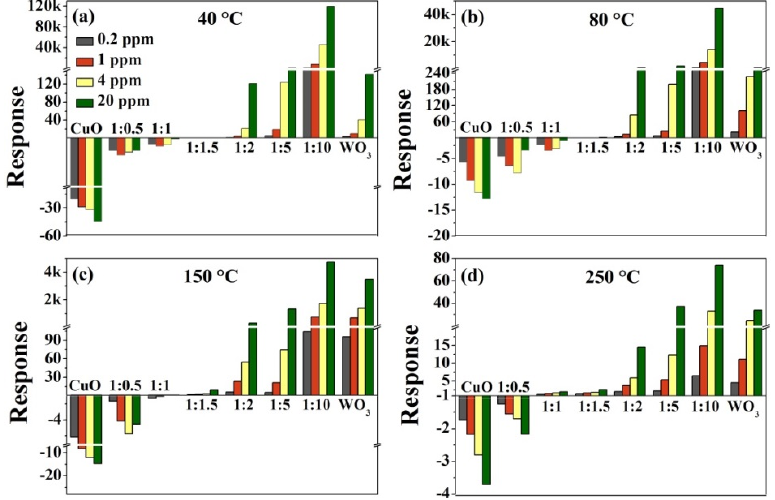
Figure 5. Responses of the CuO/WO 3 ‐ based sensors toward 0.2, 1, 4, and 20 ppm of H 2 S gas at ( a ) 40 °C, ( b ) 80 °C, ( c ) 150 °C, and ( d ) 250 °C (a negative value implies the p ‐ type response and a positive value represents the n ‐ type response).